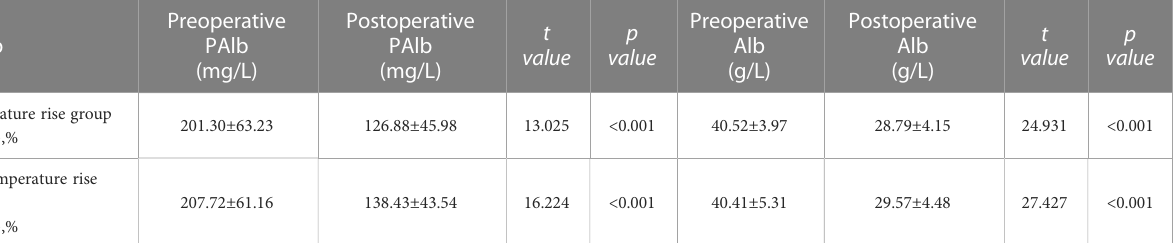
TABLE 4 Comparison of nutritional indexes between the two groups.